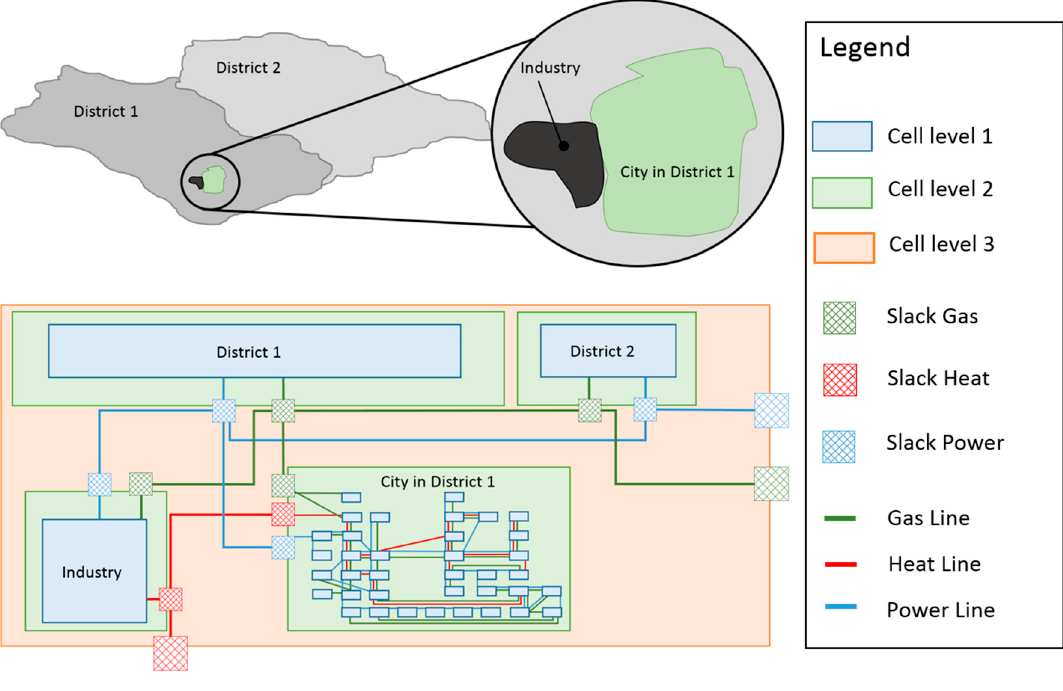
Figure 8. Topology of case study 2. Table 5. Configuration levels for case study